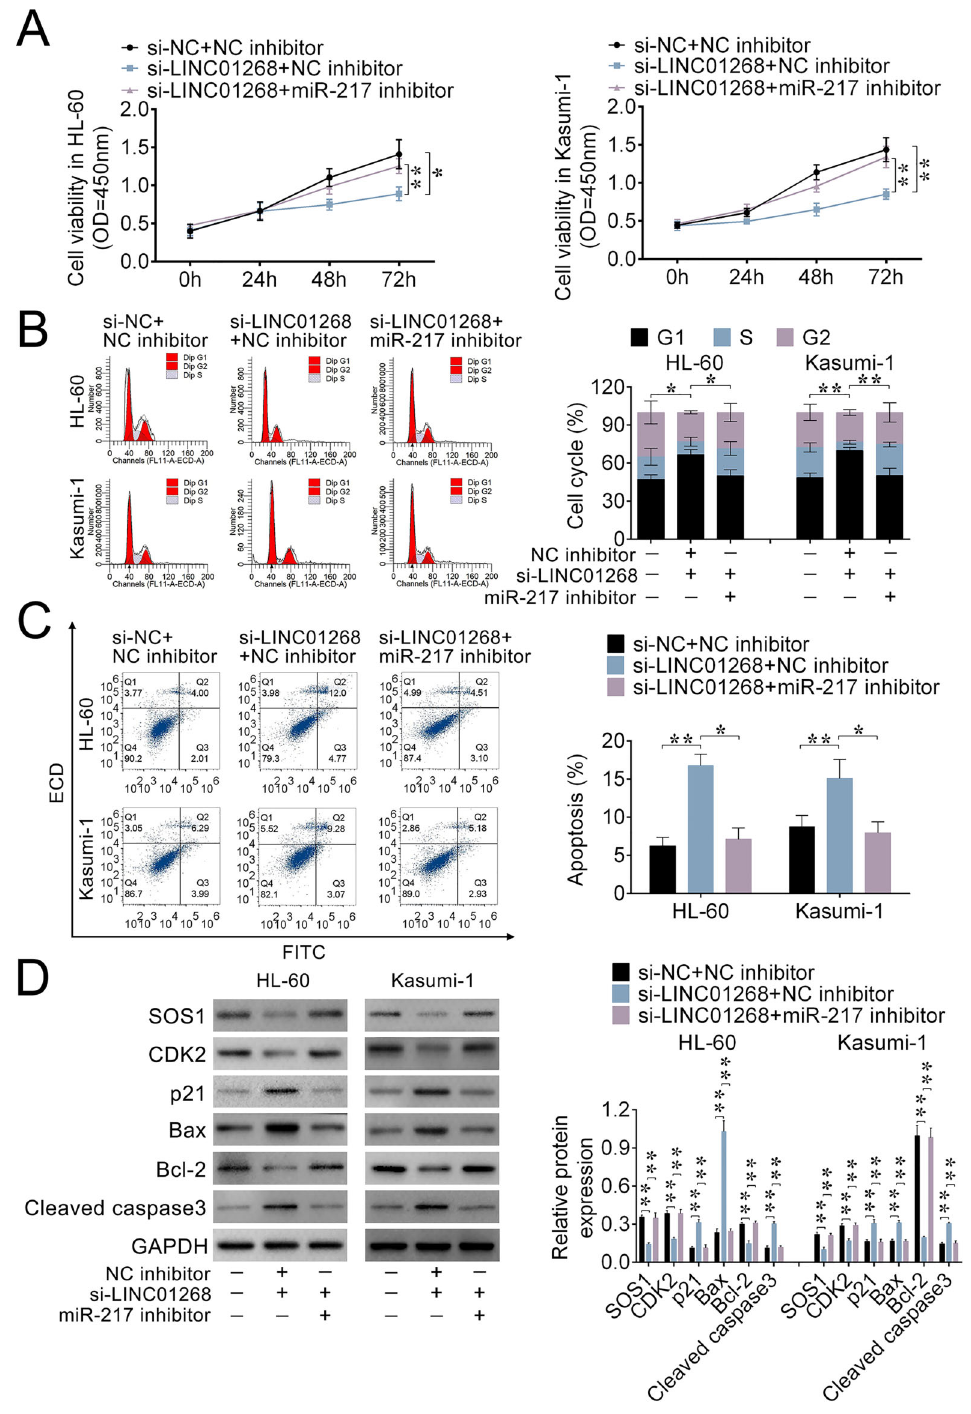
Figure 5. The roles of the LINC01268/miR-217/SOS1 axis in acute myeloid leukemia (AML) cells. After HL-60 and Kasumi-1 cells were transfected with si-LINC01268 + miR-217 inhibitor, si-LINC01268 + NC (negative control) inhibitor, or si-NC + NC inhibitor, ( A ) the cell viability was detected by CCK-8 assay; ( B and C ) the cell cycle and apoptosis were measured by fl ow cytometry; and ( D ) the protein expression of SOS1, CDK4, p21, Bax, Bcl-2, and cleaved caspase-3 were evaluated by western blot. Data are reported as means ± SD. **P o 0.01 vs the control group (ANOVA and t